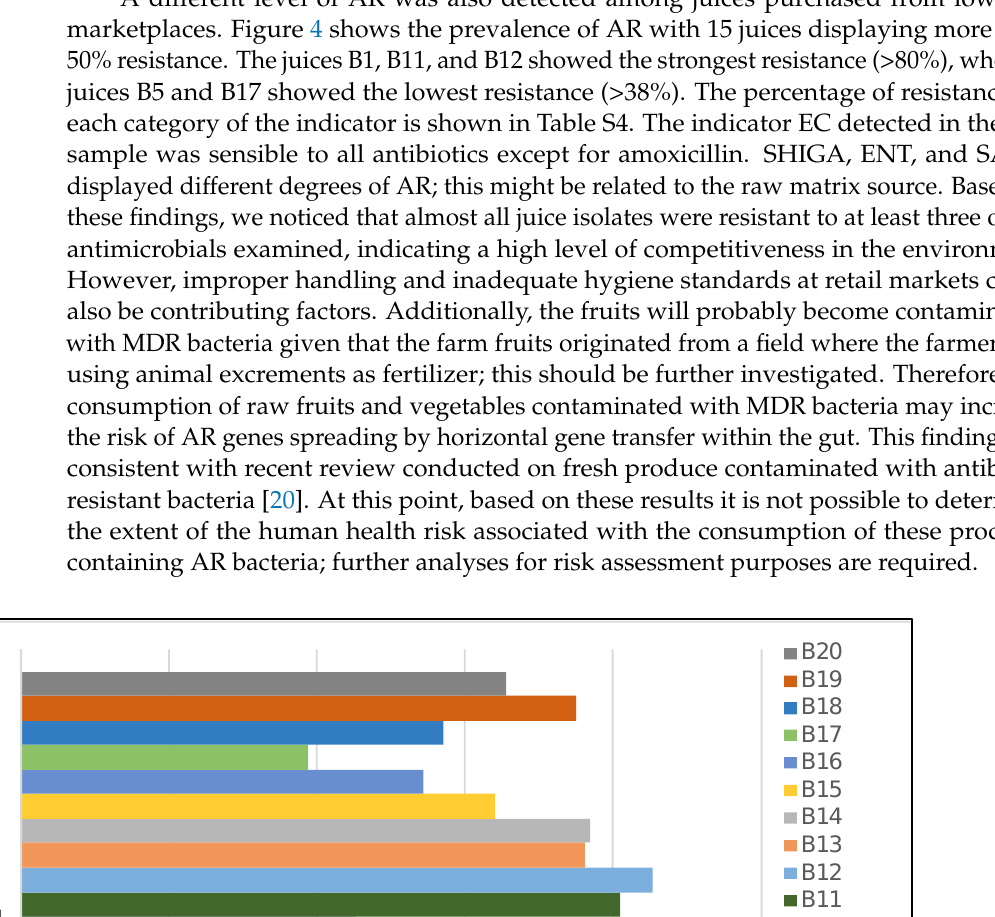
Figure 4. Level of AR (%) in juices. The bars represent the % of bacteria that showed resistance.